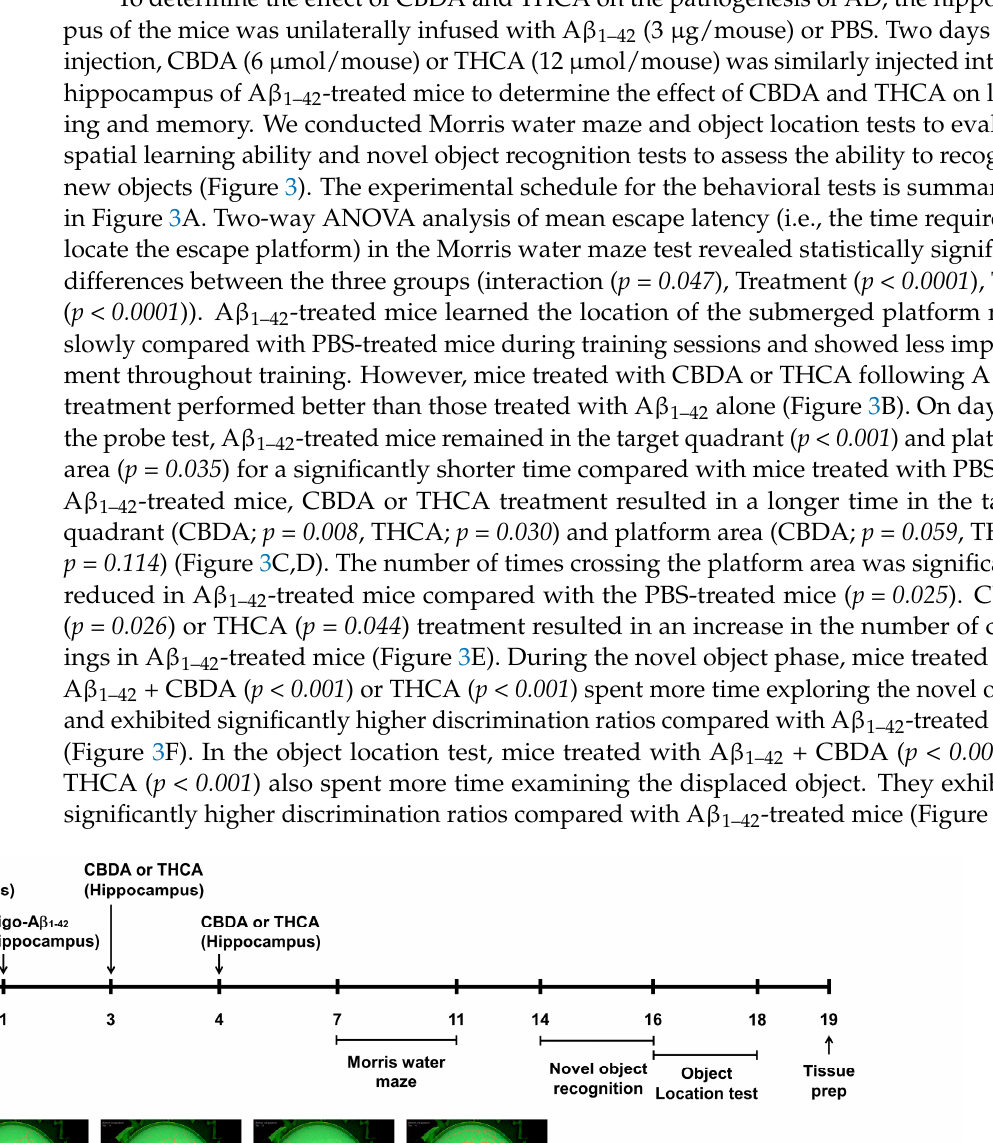
Figure 3. E ff ects of CBDA and THCA on learning and memory in A β 1-42 -treated mice. ( A ) Schedule used for the behavioral tests. ( B ) Mean escape latency results for the Morris water maze test (mean ± SEM, two-way repeated measures ANOVA, followed by Bonferroni’s post-hoc test; n = 10 per group). Time spent in ( C ) target quadrant area and ( D ) platform area. ( E ) Number of crosses in the platform area. ( F ) Discrimination ratio results for the novel object recognition test. ( G ) Discrimina- tion ratio results for the object location test. (mean ± SEM, # p < 0.05 and ### p < 0.001 vs. PBS-treated, * p < 0.05 and *** p < 0.001 vs. A β 1-42 -treated, one-way ANOVA followed by Fisher’s LSD; n = 10 per group). 2.4. CBDA and THCA Treatment Decreases A β and p-Tau Levels in the Hippocampus of A β 1-42 - Treated Mice In the acute AD-like mouse model injected with amyloid beta, amyloid beta aggrega- tion, and tau pathology, which are representative pathological markers of AD, occur [34]. So, to determine the e ff ect of CBDA and THCA on hippocampal A β aggregation and p- tau in A β 1-42 -treated mice, hippocampal tissue was collected from fi ve mice from each group 19 days after the initial A β 1-42 infusion. We conducted a Western blot analysis to measure hippocampal A β and p-tau (AT8) expression levels. The levels of hippocampal